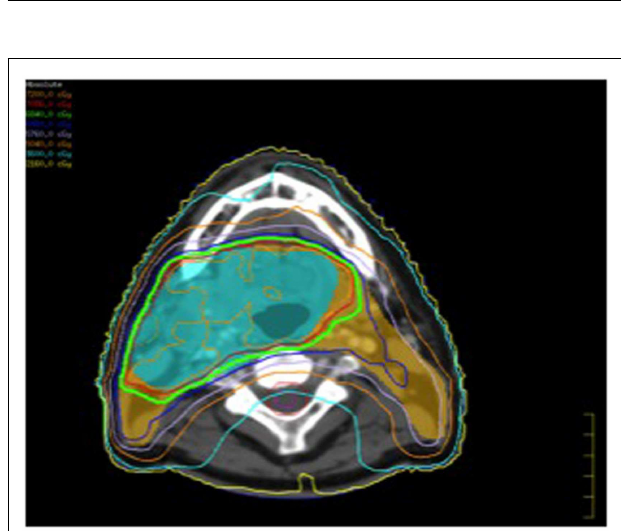
FIGURE 3 |The initial IMRT plan isodose lines (with the doses in the upper left corner) .